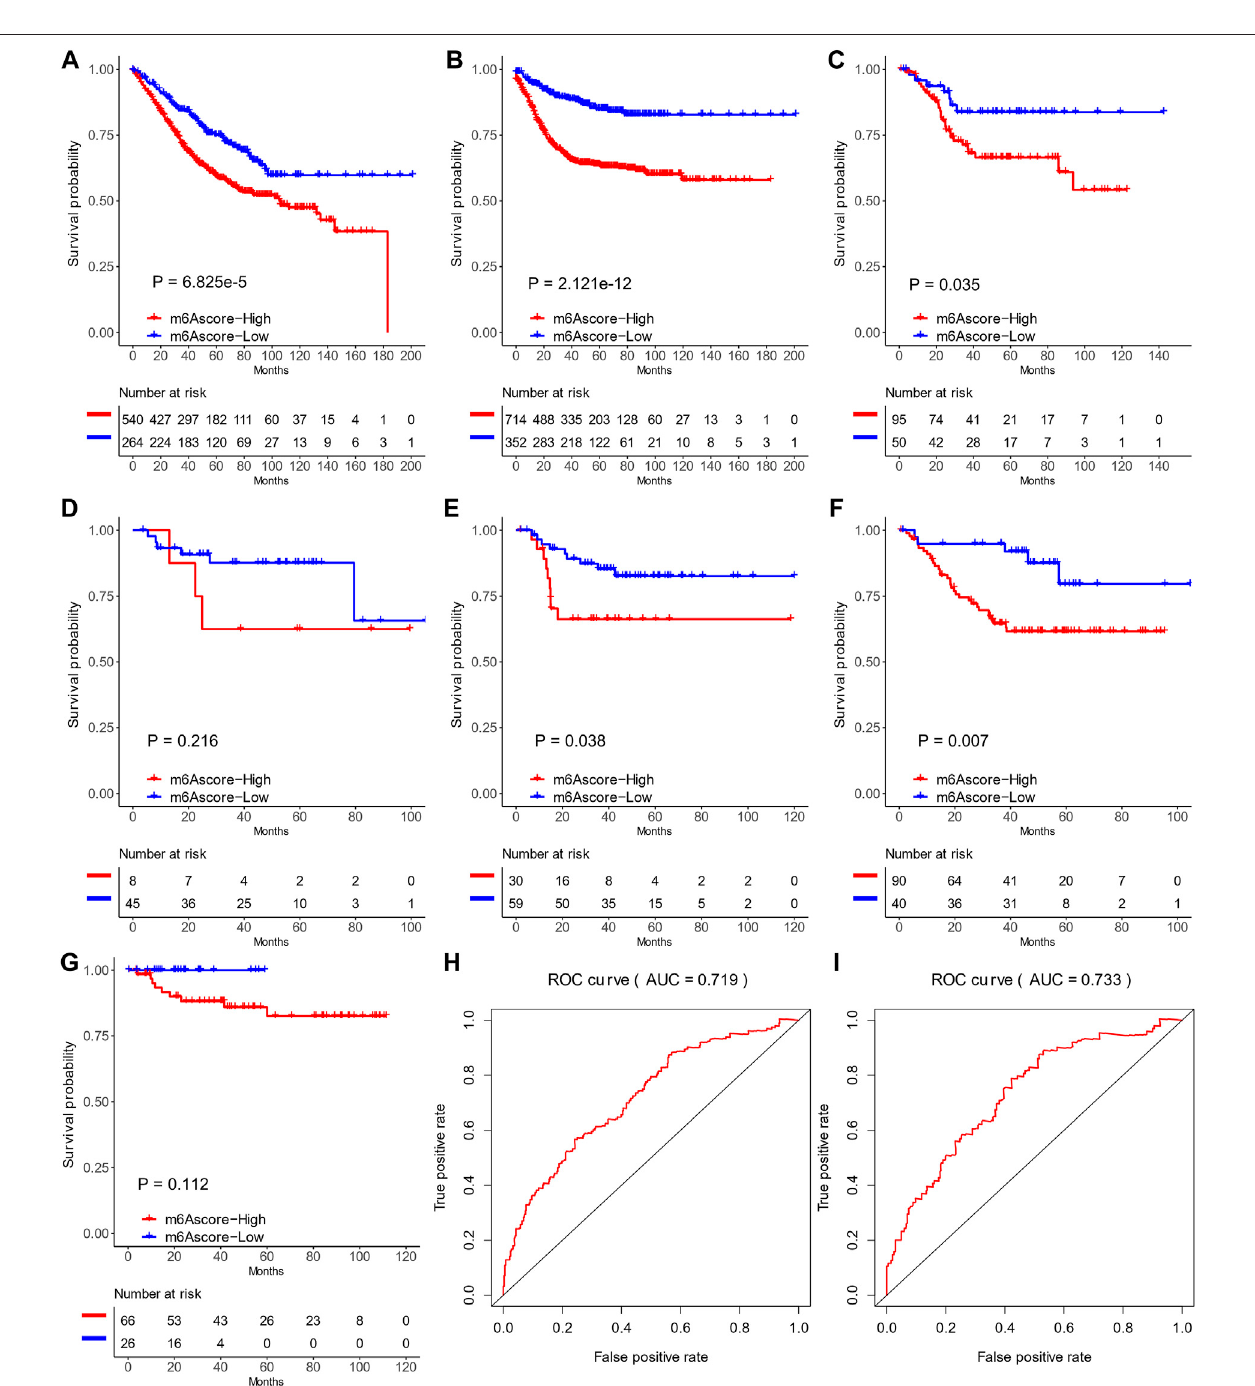
FIGURE 7 | Prediction values of m 6 Ascores in six Gene Expression Omnibus data sets. (A,B) Recurrence-free survival (A) and overall survival (B) of patients with high and low m 6 Ascores in six data sets. (C – G) Kaplan – Meier curves of patients with high and low m 6 Ascores in GSE17536 (C) , GSE29621 (D) , GSE33113 (E) , GSE37892 (F) , and GSE38832 (G) . (H,I) ROC curves of recurrence-free survival (H) and overall survival (I) in six data sets.